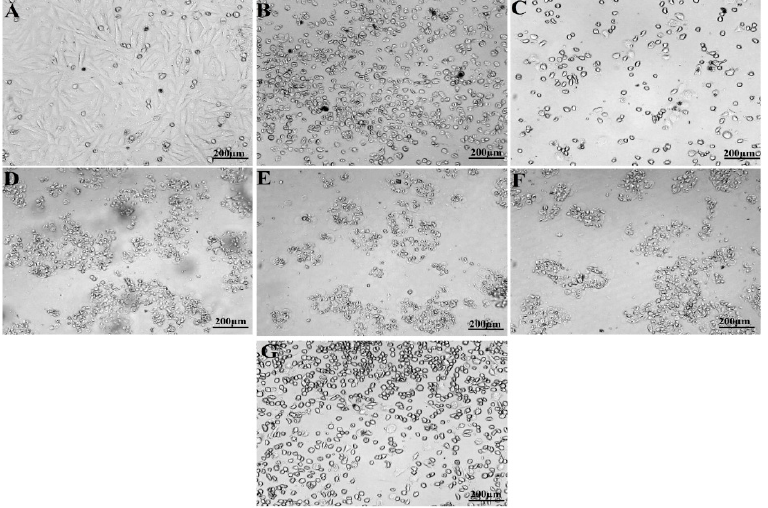
Figure 11. MTT assay of P-AgNPs from P. alba leaf extract against U118 MG cancer cell line. ( A ) Untreated cells, ( B ) Positive control, ( C ) 6.25 µg/mL, ( D ) 12.5 µg/mL, ( E ) 25 µg/mL, ( F ) 50 µg/mL, ( G ) 100 µg/mL.